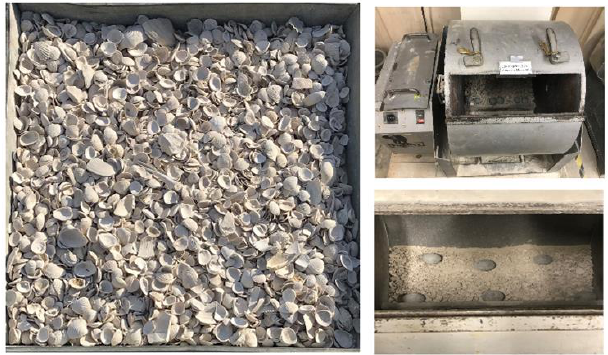
Figure 1. Florida washed shell before and after crushing.